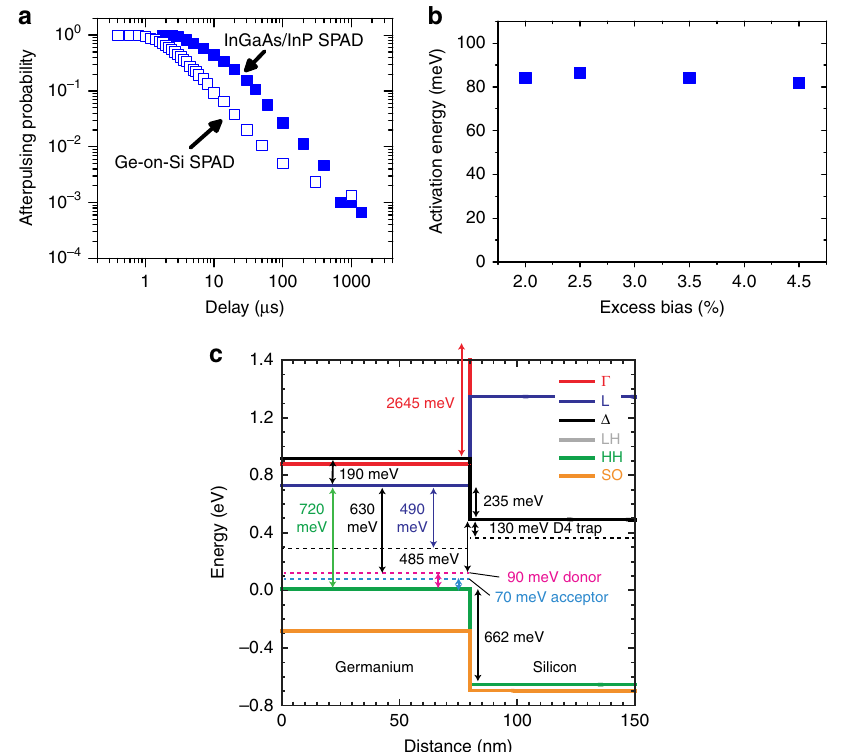
Fig. 6 Single-photon avalanche diode afterpulsing. a Afterpulsing probability as a function of gate delay time for a 100 µ m diameter Ge-on-Si single-photon avalanche detector (SPAD) (open squares) compared to a 25 µ m diameter commercially available InGaAs/InP SPAD (closed squares) when measured at λ = 1310 nm and operated at a single-photon detection ef fi ciency (SPDE) of 17% and a temperature of 125 K. b Activation energy for the Ge-on-Si SPAD as a function of excess bias. The activation energies were acquired by fi tting Arrhenius plots to the afterpulsing lifetime time constants. c The band structure at the Ge-Si heterointerface at 125 K showing the trapped defect states from dislocations (dashed lines) and the Γ valley (red line), L valley (blue line), Δ valley (black line), Light Hole (LH) band (grey line), Heavy Hole (HH) band (green line) and Split-Off (SO) band (yellow